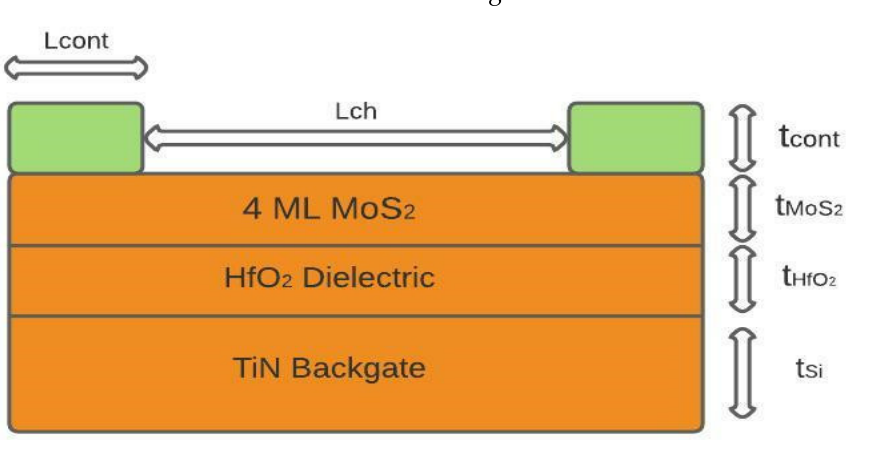
Figure 1. A schematic of the MoS 2 FET structure used in this simulation work. In this work, the authors chose the global back-gate biasing device configuration to have V th tunability (modulating V th ) for low-power applications. The following consid- erations were made in choosing the device materials of the model. Previous work done on metal-semiconductors junctions establishes that elements like titanium, platinum, and nickel form Schottky-based contacts [24]. Herein, a metal-semiconductor junction is mod- eled as Schottky, based on the work function difference between 4 ML MoS 2 (5.36 eV) and Ni (5.01 eV) contact. Electron affinity ( χ o ) of 4 ML MoS 2 is taken to be 5 eV. The metalwork function and Richardson constant are given as input to the model [10,24]. The potential at the contact is defined as where V 0 , φ B and V eq are applied potential, the work function of metal and offset in Fermi level in terms of potential applied respectively. An N-type dopant concentration of 10 18 cm − 3 is used in the simulation. The simulations are performed in a 4-multilayer (4 ML) thick MoS 2 with an average thickness of 2.7 nm. A 4 ML MoS 2 is chosen considering the trade-off between bandgap and field-effect mobility. To elaborate, devices with smaller bandgap (>10 ML MoS 2 ) result in a larger Schottky barrier height value at the contact (non-ohmic contact) but would show excellent channel mobility (>45 cm 2 /Vs). In contrast, devices that form ideal ohmic contact require a larger bandgap (1–2 layers of MoS 2 ) but show very low values of mobility (<20 cm 2 /Vs) [25], as neither too large a bandgap nor very low mobility as the material of choice. The dielectric is chosen to be high-k HfO 2 as this shows improved effective oxide thickness resulting in higher transconductance with minimal leakage. Replacing increased threshold voltage due to poor gate-dielectric bonding and non-uniform surface trap charges. In order to mitigate this issue, metal-like TiN is the material of choice for the back-gate, as this has a mid-gap work function along with its tunable work function with film thickness. The gate oxide used is 1 nm HfO 2 which is placed over a thin TiN back-gate contact (~1 nm). Ni is chosen as the source and drain contact material, as the Ni-MoS 2 interface shows minimal Schottky barrier height (SBH), thus having implications on contact resistance but without affecting mobility. All other input parameters to the model are listed in Table 1. The mobility value used in this model agrees with the value mentioned in a published work that too states mobility of 42 cm 2 /Vs for multilayer (few tens of nm thick devices> 15 layers) devices owing to the limitations in channel-contact interface